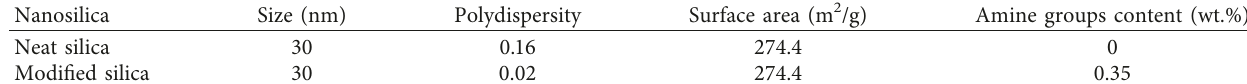
Table 2: Characteristics of nanosilica fillers.